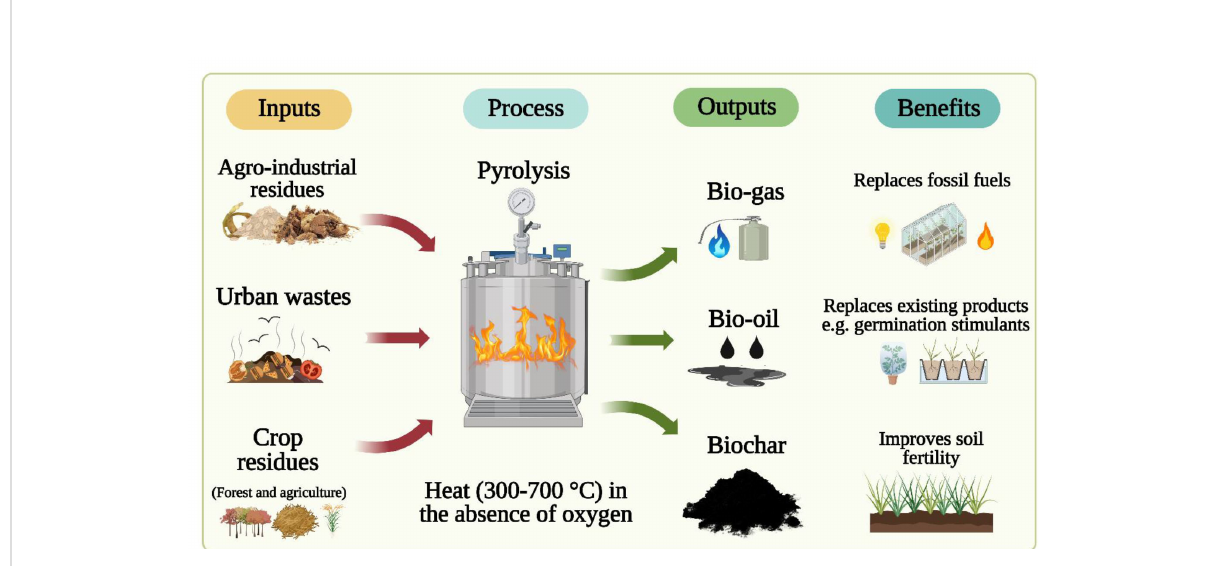
FIGURE 1 Illustration of biochar (BC) manufactured from various solid waste materials (left) and the transformation of these waste materials into useful products via pyrolysis (middle) and the associated horticultural bene fi ts